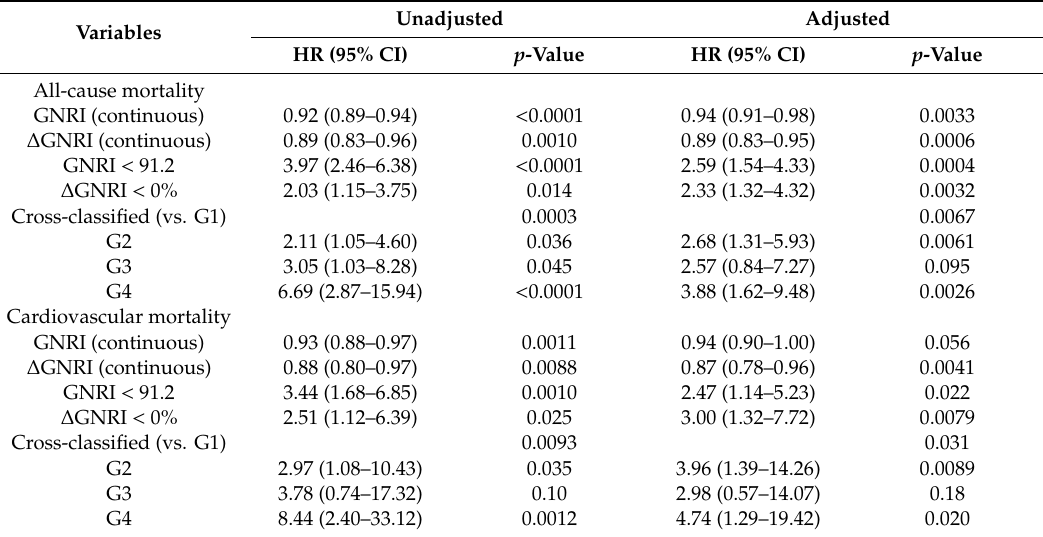
Table 2. Cox proportional hazards analysis of baseline GNRI and annual change in GNRI of